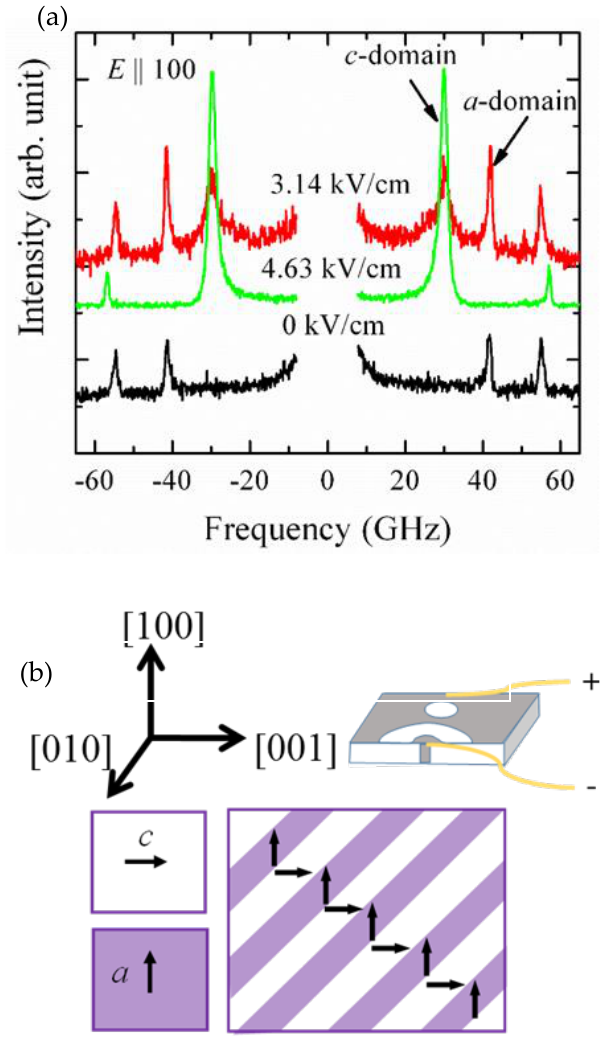
Figure 5. ( a ) A set of typical Brillouin scattering spectra BTO single crystals in the ferroelectric tetragonal phase at some selected electric fields at 303 K; ( b ) shows the orientation of a and c domains.